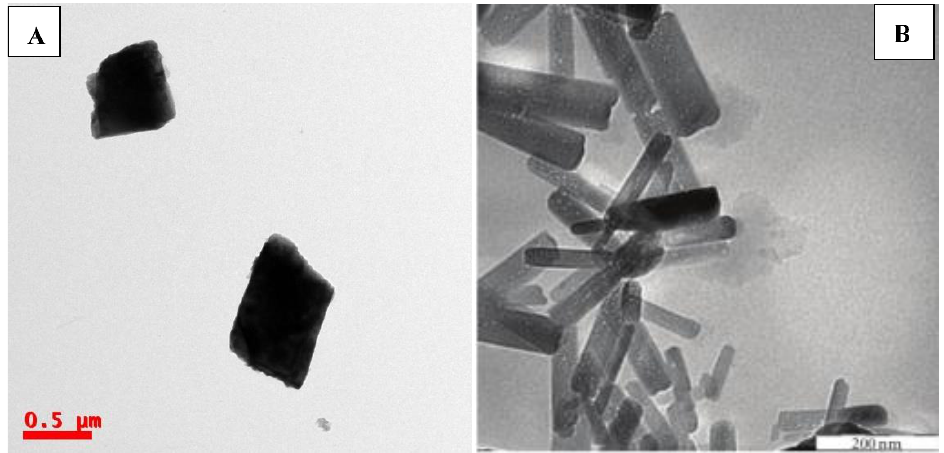
Figure 12. Transmission electron microscopic images of ( A ) calcium carbonate of microparticles and ( B ) aragonite nanorods adapted from (Islam et al., 2012).